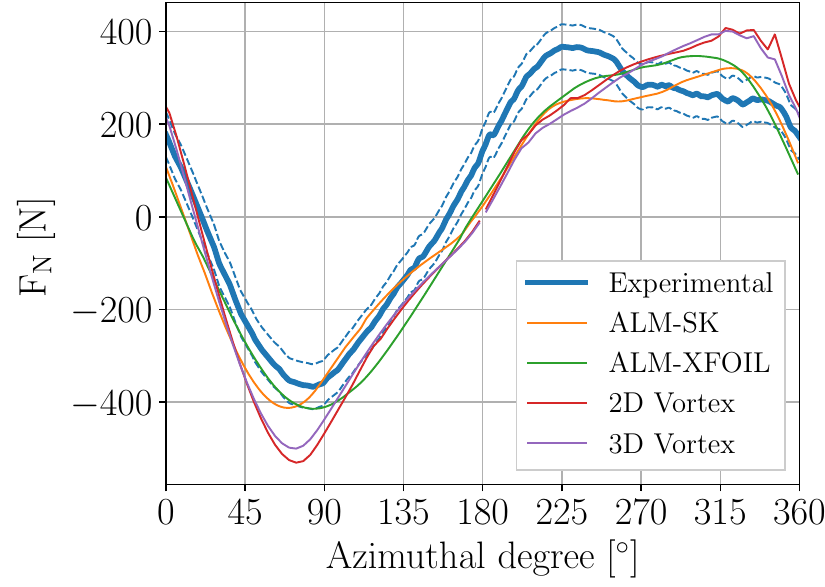
Figure 8. The normal force response at λ =